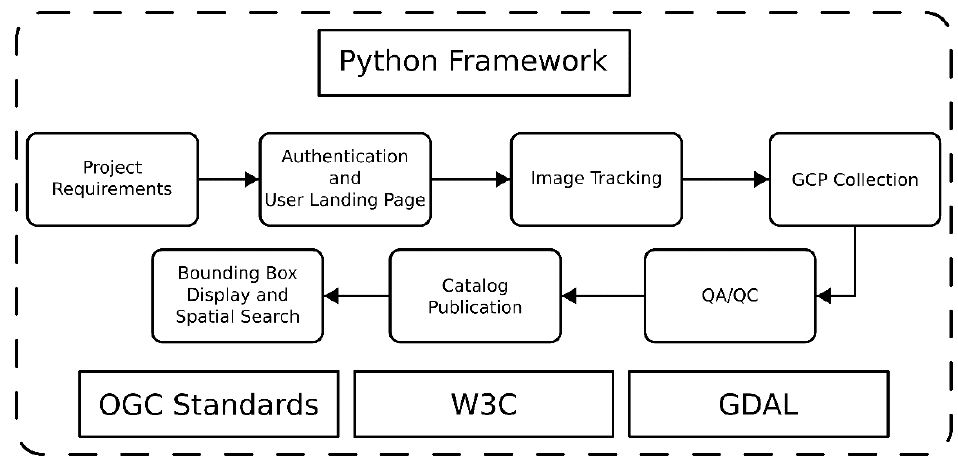
Figure 1. The flowchart of the development procedures of the georeferencing web application.